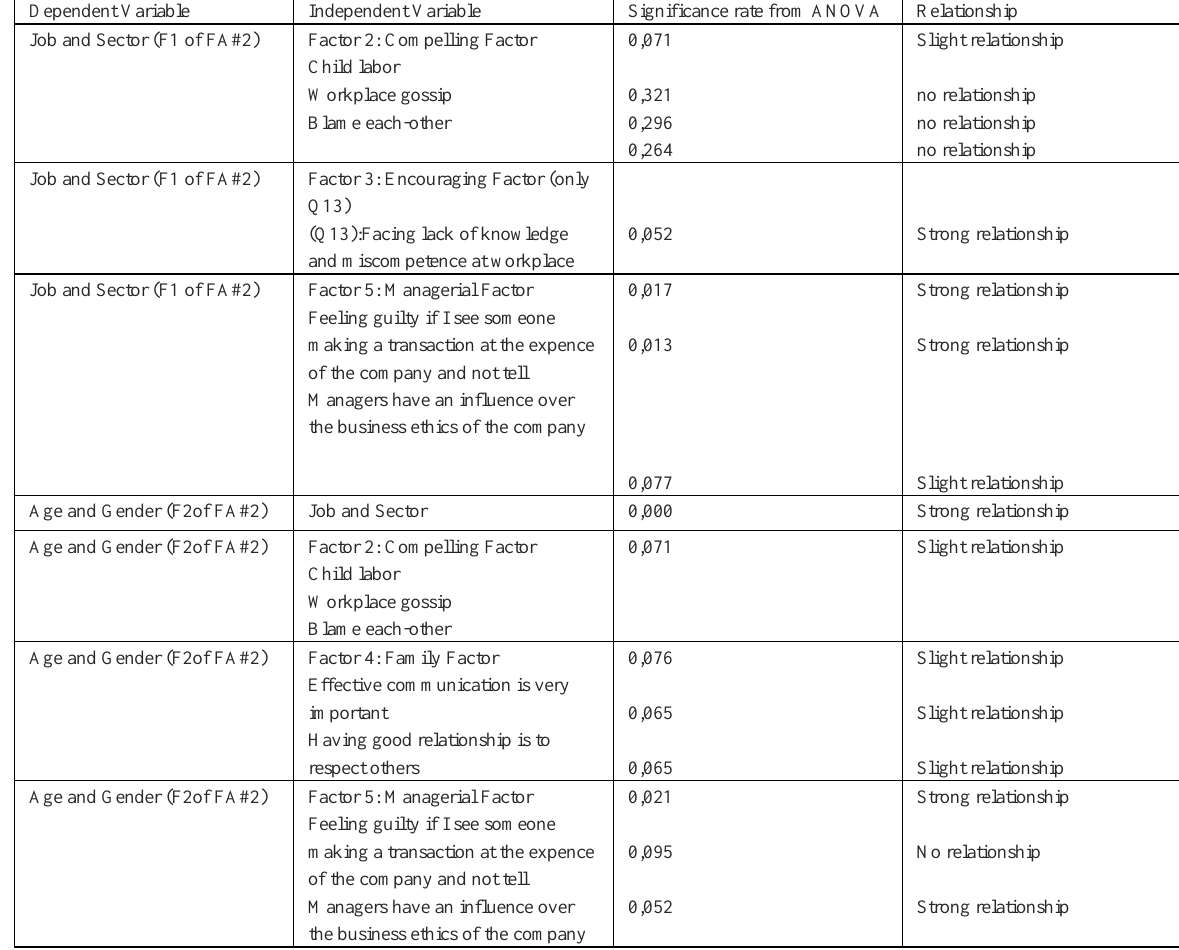
Table 6: ANOVA Analysis Results